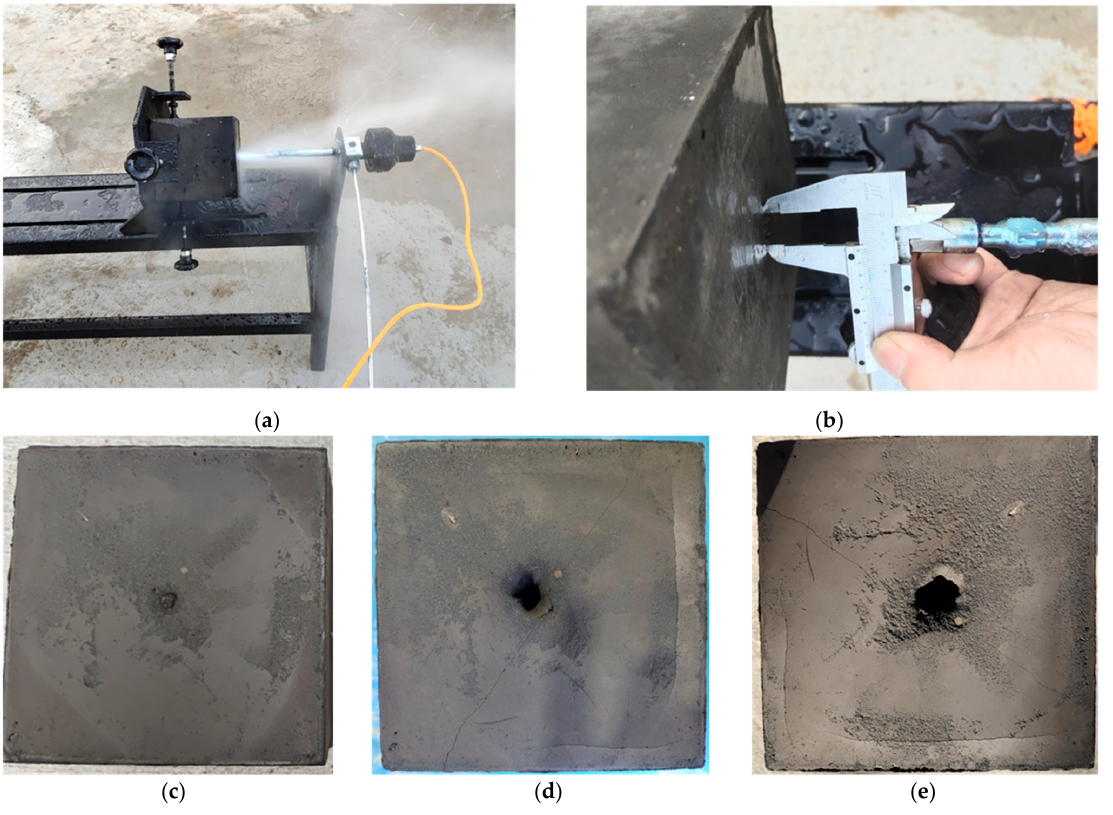
Figure 14. Experiment of punching: ( a ) the punching process; ( b ) measurement of results; ( c ) punch- ing effect of the nozzle 1; ( d ) punching effect of the nozzle 2; ( e ) punching effect of the nozzle